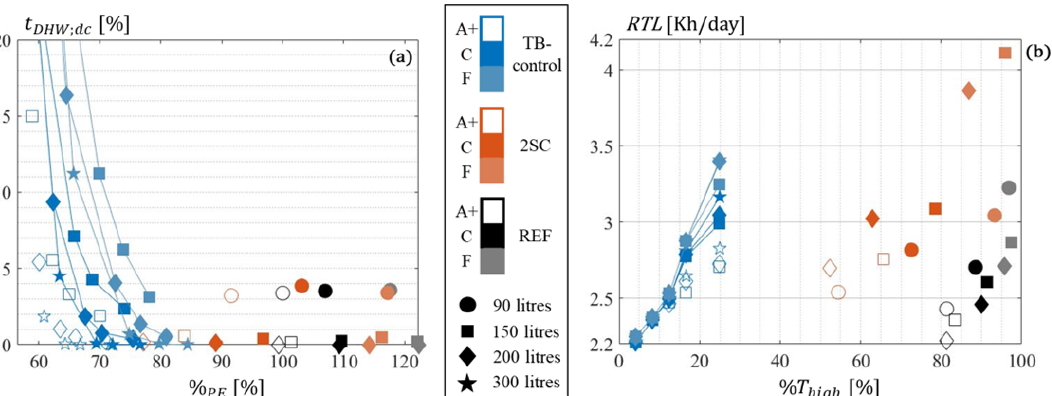
Figure 10. Results for reducing the insulation level of DHW vessels for the three control strategies. The results for t DHW ; dc and % PE are shown in ( a ), and ( b ) shows those for RTL and % T high . The shape refers to the DHW vessel volume, the colour (black, red or blue) to the control strategy, and the greyness of a given colour to the insulation level (white face colour is A+; more grey variant is F).